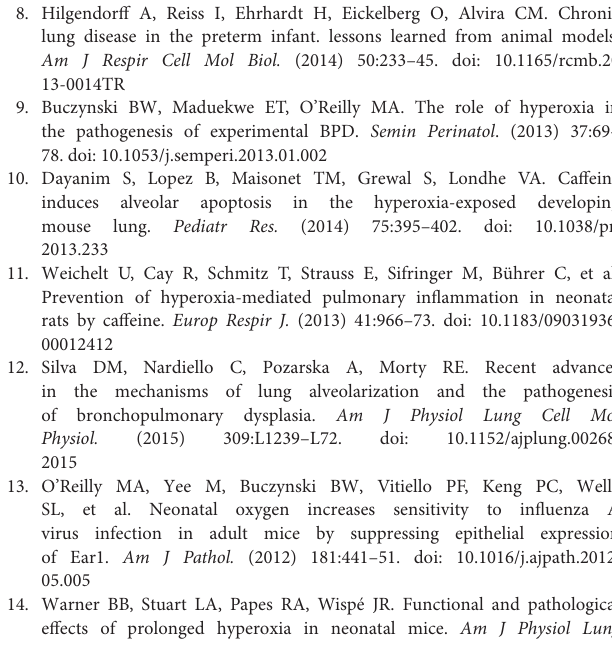
Supplementary Figure 1 | Oxygen exposure models trialed in this study. Within 12h of birth, neonatal C57BL/6 mice were exposed to (A) 75% O2 for 5 [PN1-5], (B) 8 [PN1-8], or (C) 14 days [PN1-14] with a daily 3-h period in room air (not shown in figure). Cohorts of mice were analyzed at PN14 or PN40, and for the PN1-14 model at PN80 (red arrows) alongside room air control mice. Body weights of room air control mice and oxygen-exposed mice at (D) PN14 or (E) PN40. ∗∗ P < 0.01 and ∗∗∗ P < 0.001 by Mann-Whitney U -test (2-tailed). n ≥ 6 mice per group, with 1–2L used in the analysis of each oxygen group. Gender is represented by closed symbols (male) and open symbols (female). PN, postnatal. Supplementary Table 1 | Custom imageJ script used for the quantitation of fluorescence positive